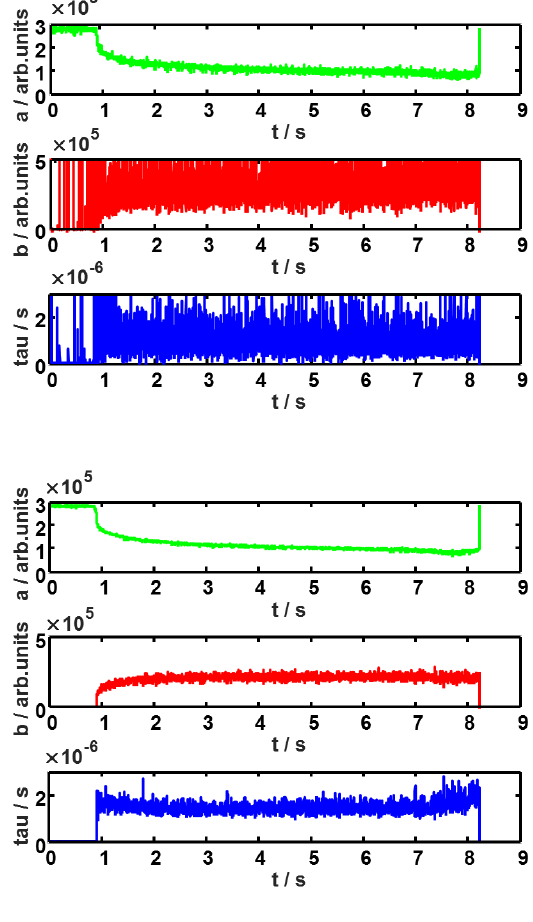
Fig. 6: Local signal approximations with and without time rescaling for spheroid in nozzle. A : Whole spectrum. B : Zoom at higher frequencies.